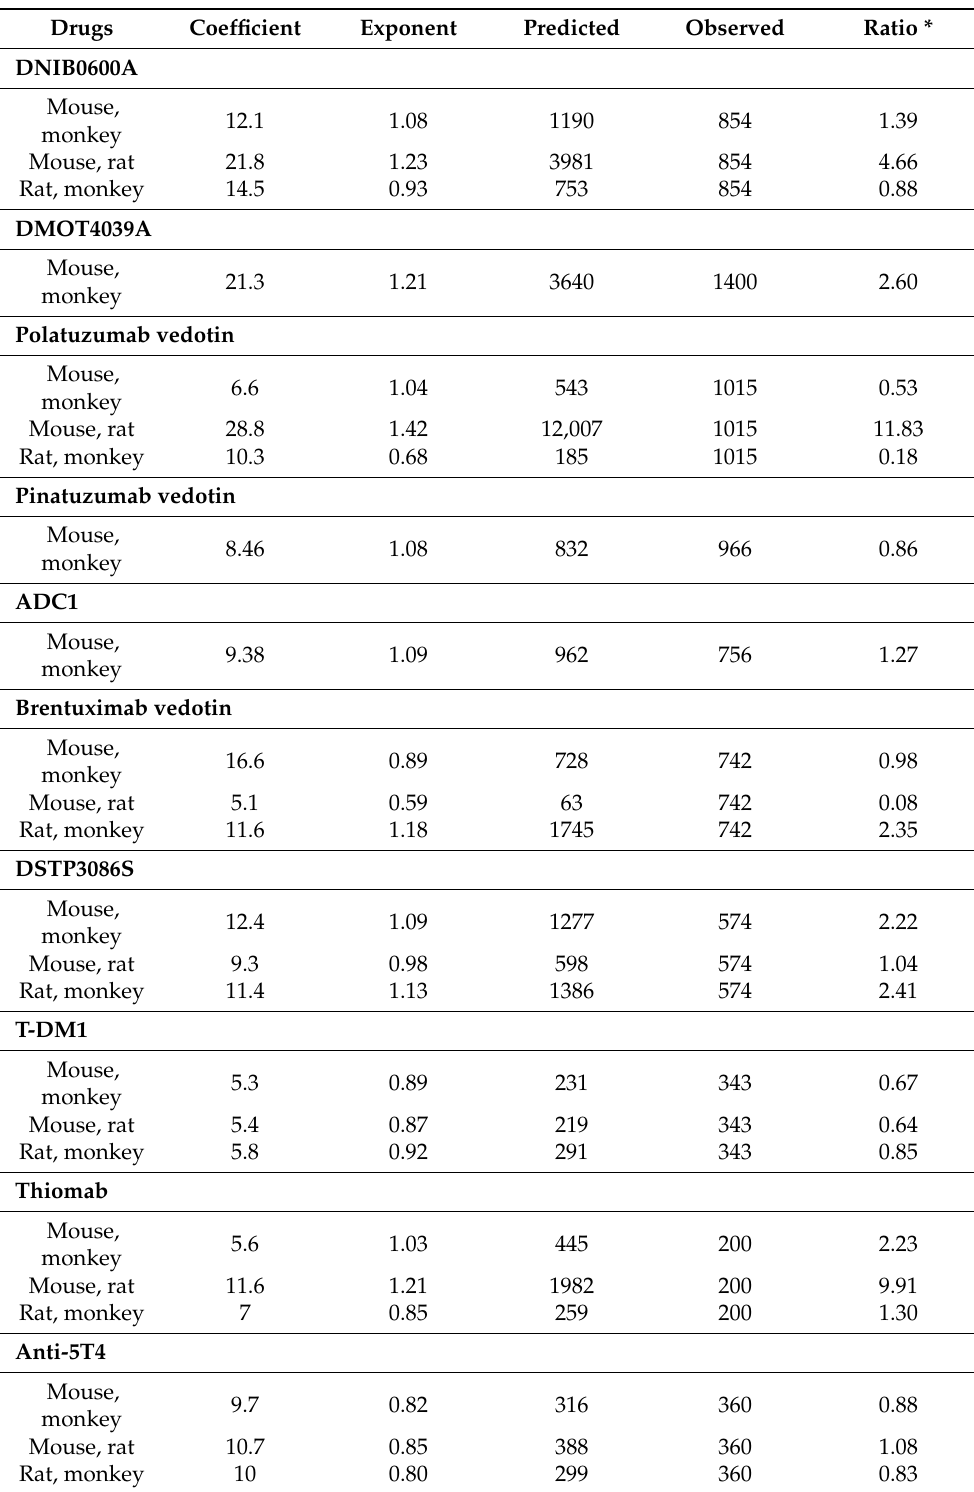
Table 4. Prediction of human clearance of total antibody by two-species allometric